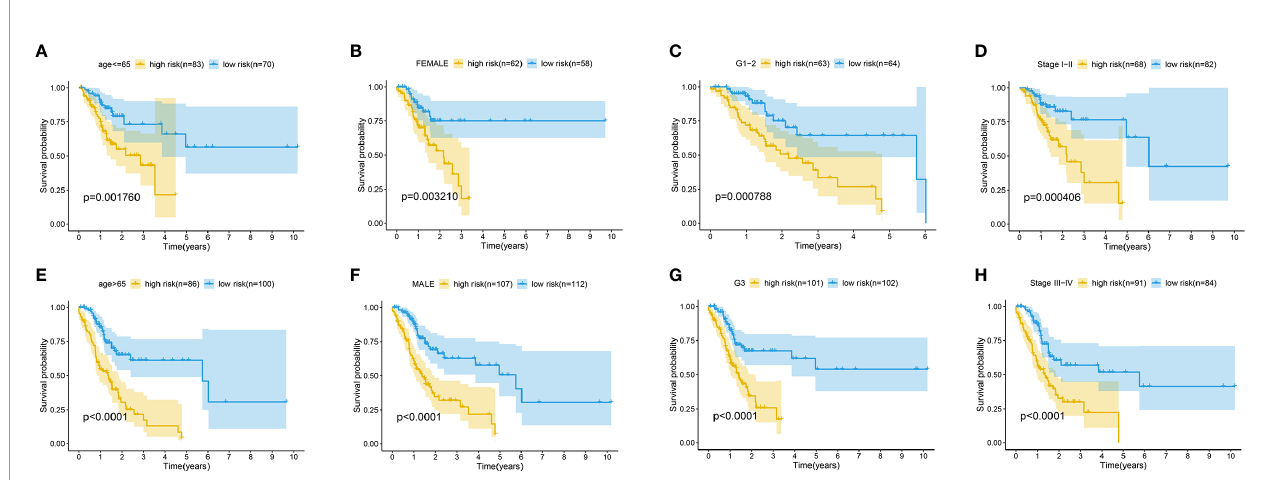
FIGURE 5 | Kaplan-Meier survival curves for the high-risk and low-risk groups strati fi ed by clinical factors including age (A, E) , gender (B, F) , grade (C, G) , and stage (D, H) in the complete